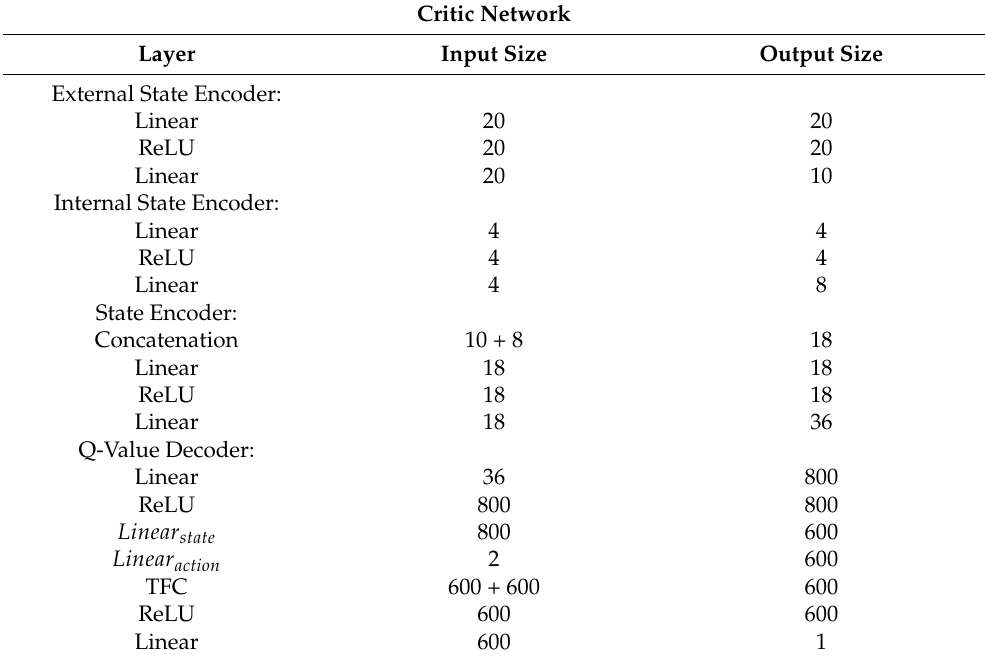
Table 2. Network parameters and structure of both critic